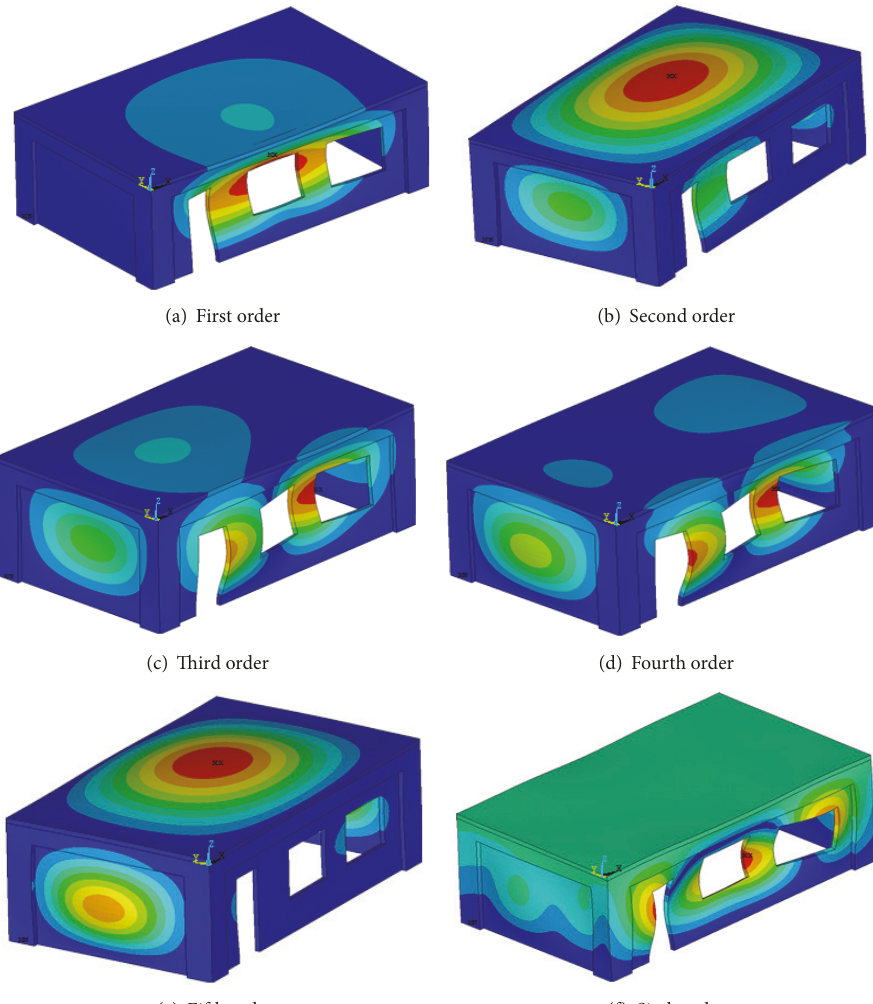
Figure 4: The top six vibration shapes of the masonry structure.